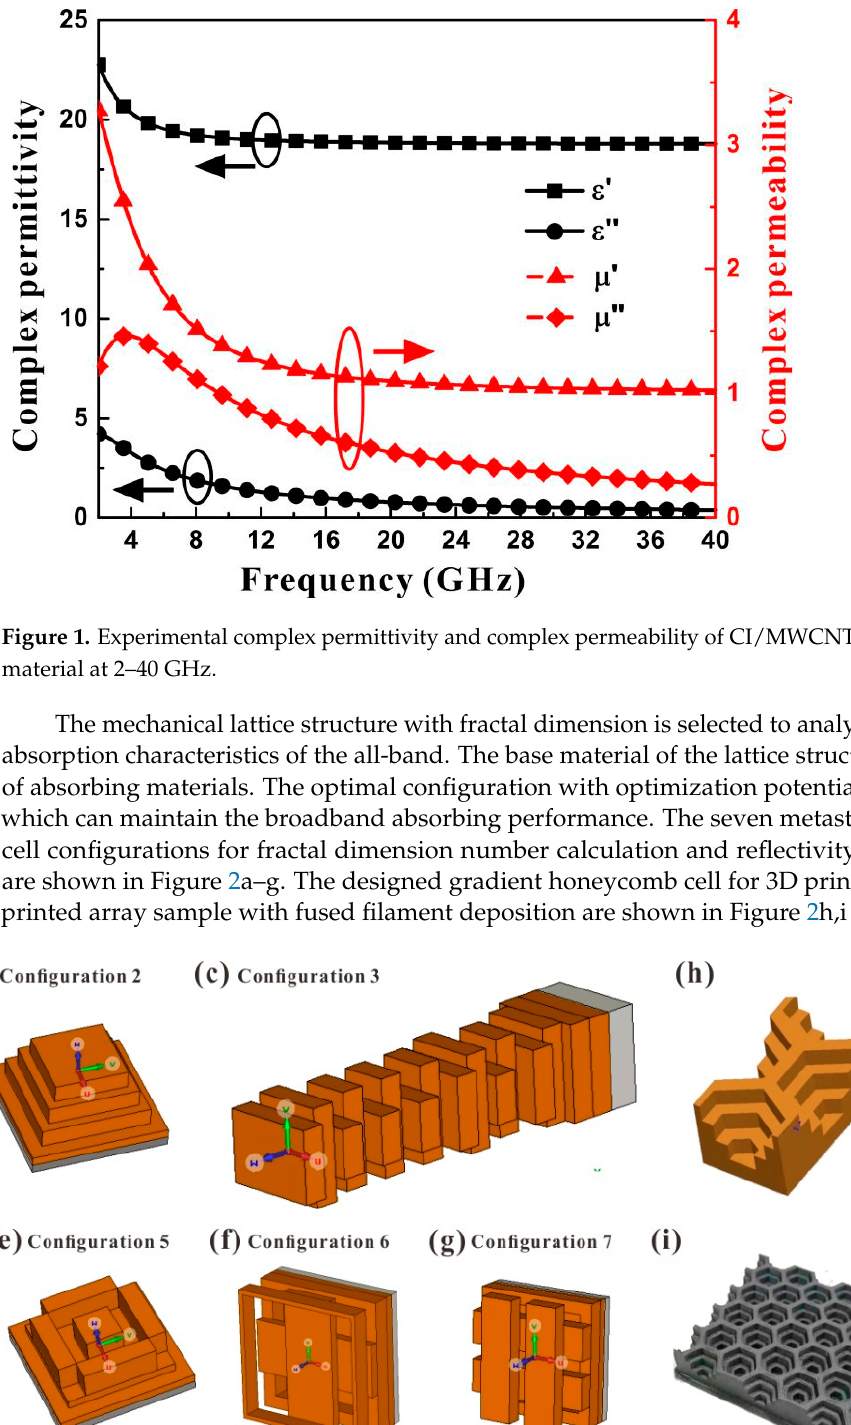
Figure 2. ( a – g ) Seven electromagnetic metastructure configurations (Configuration 1 to 7) for fractal dimension number calculation and reflectivity simulation. ( h ) Designed gradient honeycomb cell for 3D printing. ( i ) The printed gradient honeycomb metastructure sample fabricated by fused filament deposition with blue print shown in ( h ).